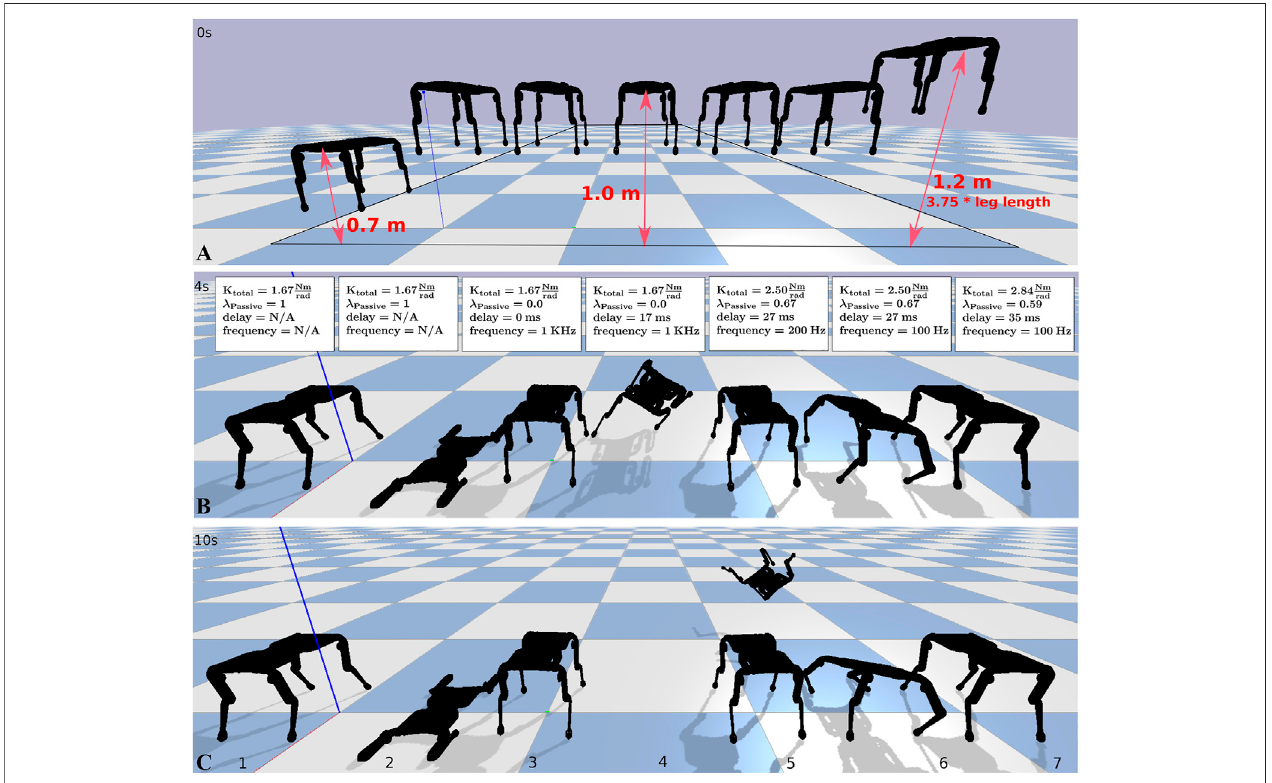
FIGURE 8 | Computer simulated quadruped robots landing, in seven different scenarios, controlled with a duty cycle of 100%. (A) The robot ’ s initial drop heights areindicatedwithredarrows. (B) Anintermediate robotstateat4 ssimulationtime.Thepanelsalsoprovidecontrollerparameters. (C) Converged robotstateafter10 s. Cases 1, 3, 5, and 7 landed successfully.